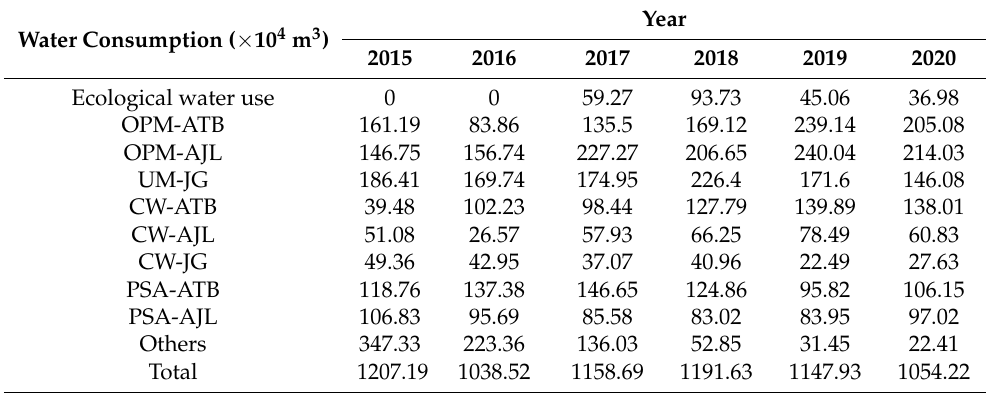
Table 3. Water consumption in the study area from 2015 to 2020. OPM-ATB denotes open pit mining of the Antaibao (ATB) mine. OPM-AJL denotes open pit mining of the Anjialing (AJL) mine. UM-JG denotes the underground mining of Jinggong (JG) No. 1 mine. CW denotes coal washing. PSA denotes production support